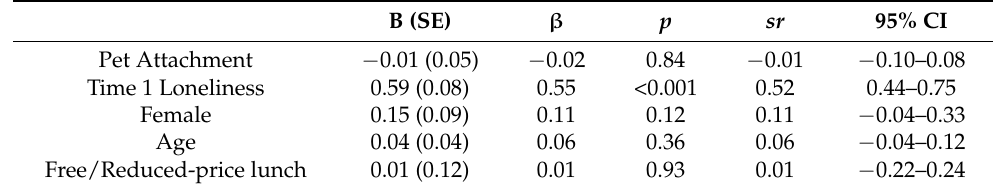
Table 5. Pet attachment predicting Time 2 loneliness, controlling for Time 1